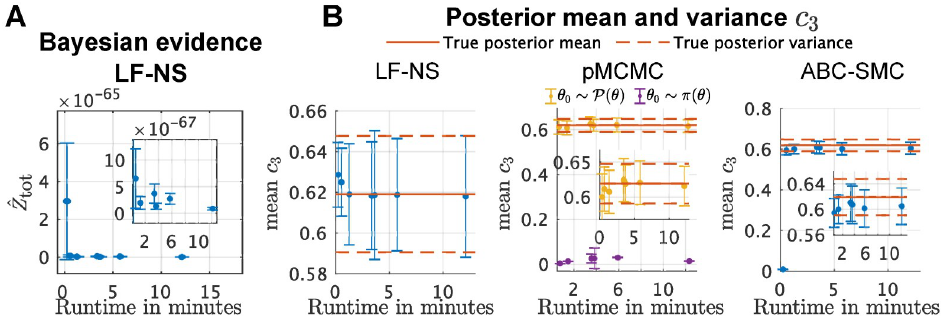
Fig 6. Runtime comparison between LF-NS, pMCMC and ABC. A : The estimated Bayesian evidence for the different LF-NS runs. The error bars indicate the standard deviation of the final BE estimate. B : The estimated mean and standard deviation of the marginal posterior for c 3 for the different algorithm runs. The solid red line indicates the mean and standard deviation of the true marginal posterior for c 3 .